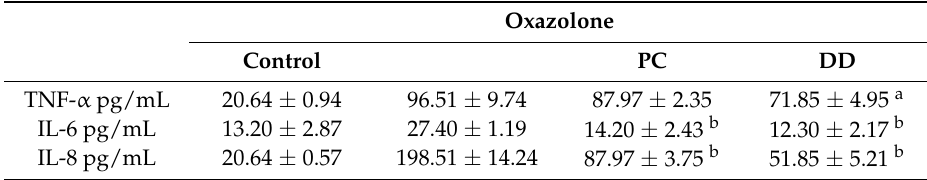
Table 2. ELISA analysis showing oxazolone-induced increase in IL-1 β production in the absence and presence of Z-YVAD-FMK in HaCaT cells. P. cicadae and D. dasycarpus abolished oxazolone–induced increase in IL-1 β .